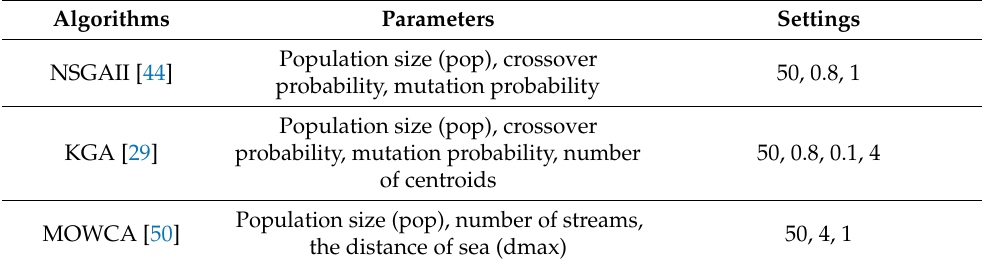
Table 5. Different algorithms and the setting parameters. Algorithms